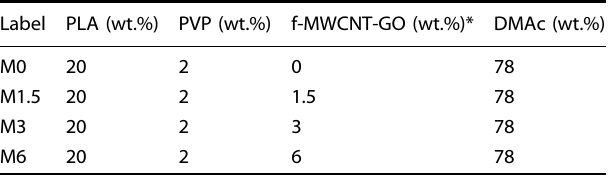
Table 1. Compositions of dope solutions used in the fabrication of